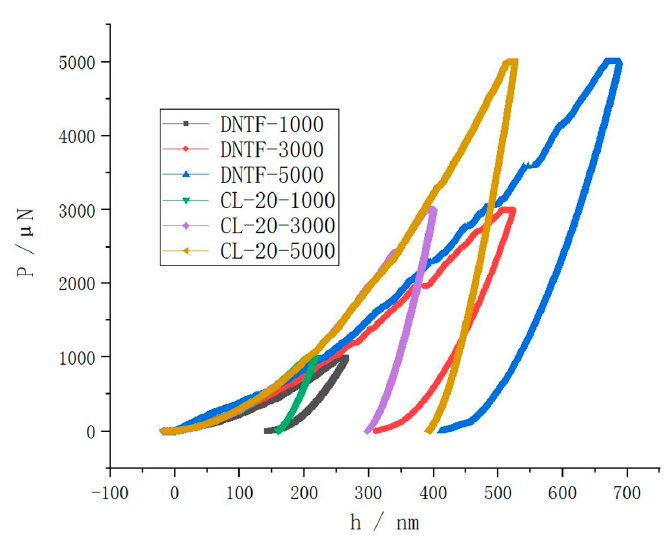
Figure 3. DNTF, CL-20 crystal load–displacement comparison curve.